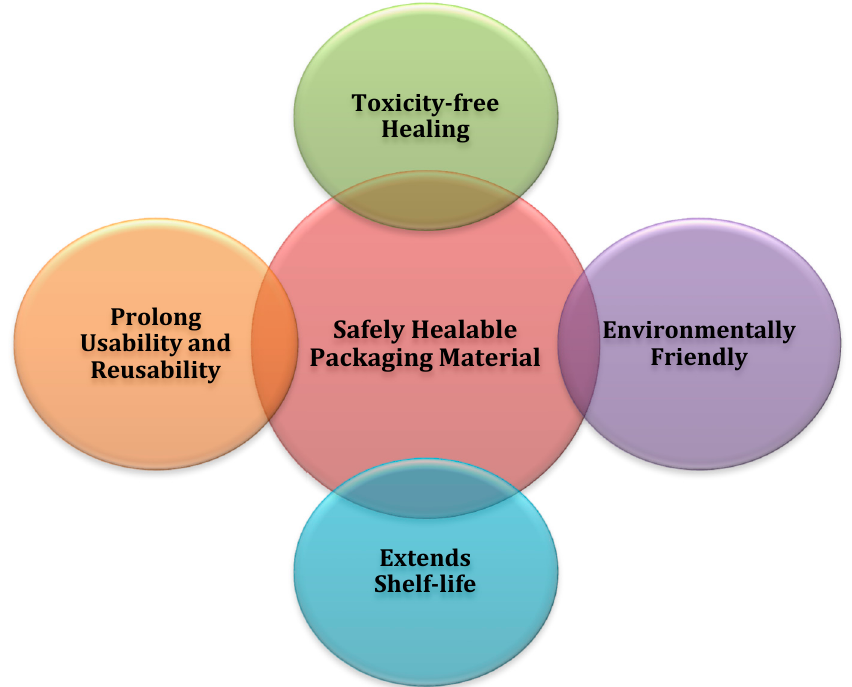
Figure 9. Features and functions of safely healable packaging materials.